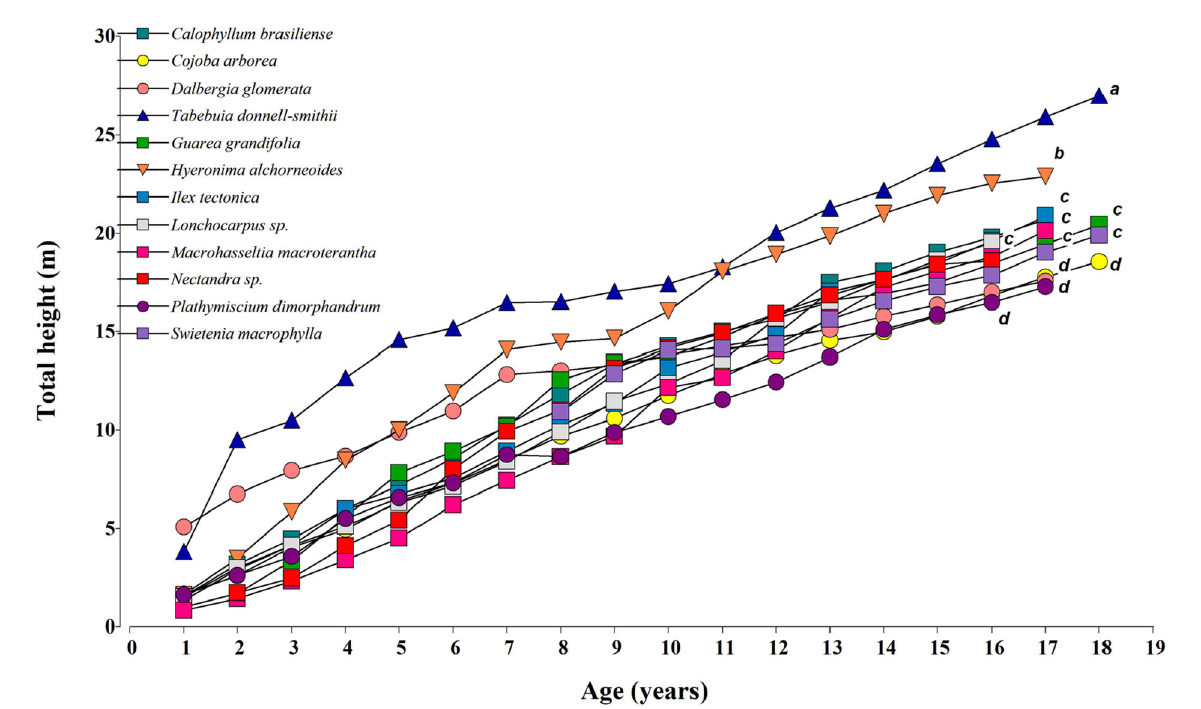
FIGURE4 Total height growth rate curves (m) of 12 timber shade species in the experimental site “CEDEC-JAS”, La Masica, Atlántida, Honduras. Means with different letters are statistically different (DGC test , p <